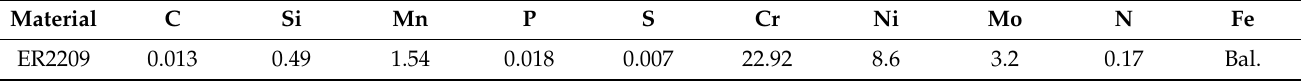
Table 1. Chemical composition of welding wire